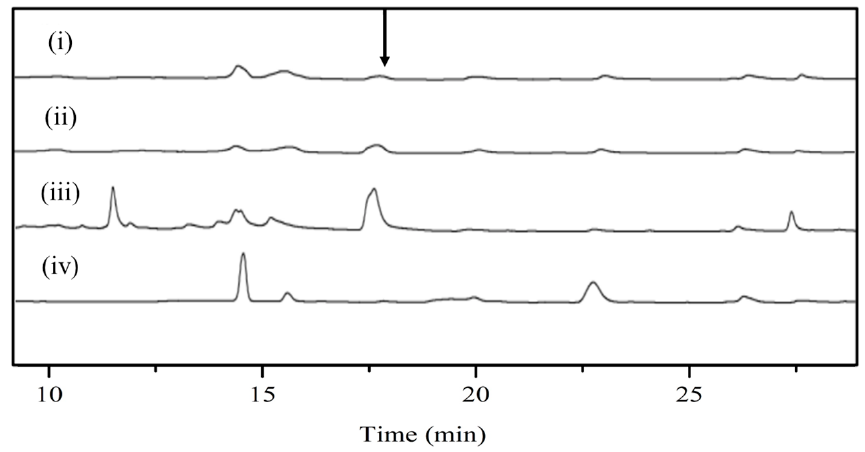
Figure 5. HPLC analysis of DnmSQ-catalyzed reverse glycosyltransfer reaction. All enzyme assays were performed in a total volume of 100 µ L in Tris-HCl buffer (10 mM, pH 7.5) containing 1 mM of MgCl 2 with incubation at 30 ◦ C for 12 h. The enzyme used in the reverse glycosyltransfer reactions here refers to the cell lysate supernatant. (i) 100 µ M DnmQ, 50 µ M DNR and 2 mM TDP; (ii) 100 µ M DnmS, 50 µ M DNR and 2 mM TDP; (iii) co-incubation of 100 µ M DnmS and 30 µ M DnmQ, 50 µ M DNR and 2 mM TDP; and (iv) control with 50 µ M DNR and 2 mM TDP in the absence of enzyme resulted in no reaction. The black arrow indicates the new peak.